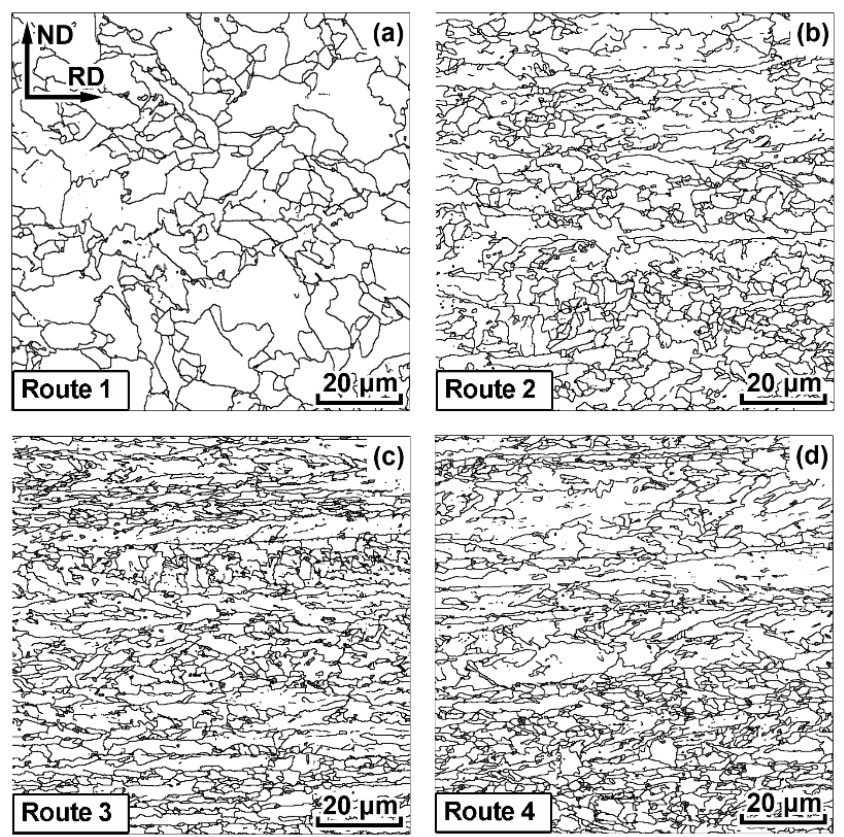
Figure 2. EBSD analysis of grain structure of the pipe steel specimens after TMCP.